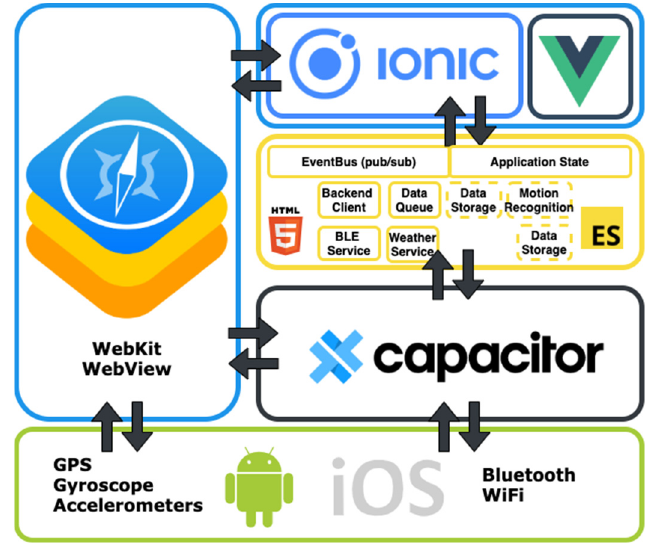
Figure 4. Block diagram of the mobile application.